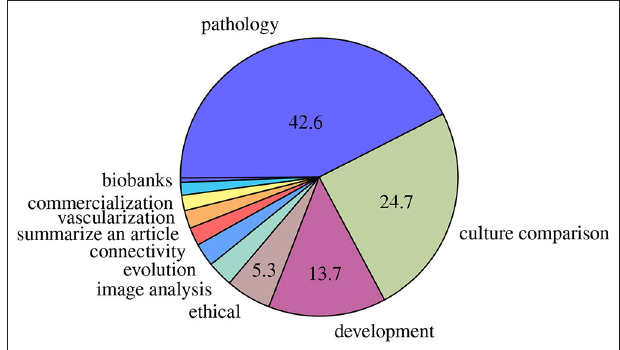
FIGURE 2 | Main domains of reviews published. Percentages < 5% are not